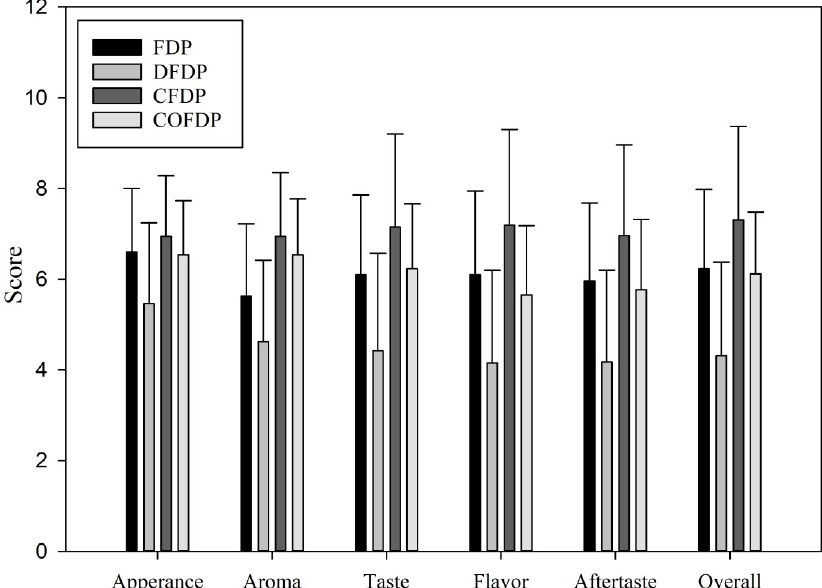
Figure 1. Sensory evaluation results of fermented Taiwan djulis and other similar fermented dairy products. FDP: Fermented dairy products; DFDP: Taiwan djulis fermented dairy products; CFDP: Cereal fermented dairy products; COFDF: Commercial original fermented dairy products. The number of evaluations was 52, and the results were expressed as mean ± SD. Different letters indicate significant differences from each other.